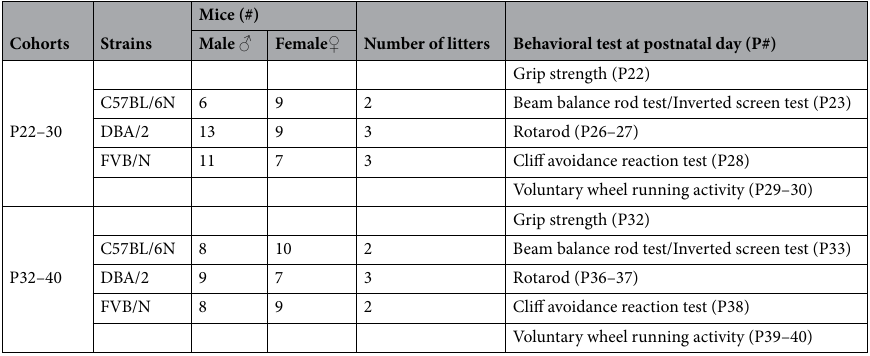
Table 1. Mouse cohorts, number and age of the adolescent mice used in the different